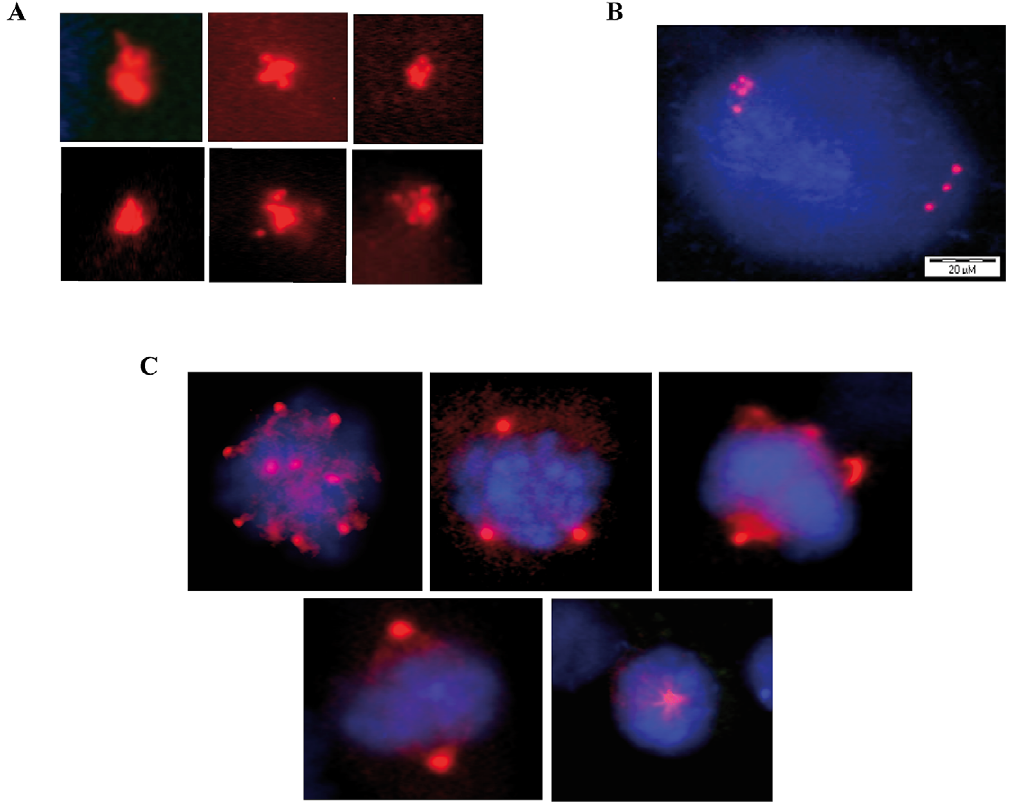
Fig. 5. Immunofluorescence with anti- γ -tubulin antibody (red) showing morphological features of aberrant centrosomes in the glioma cell lines. Magnification 63 × or 100 × . Scale bars = 20 µm (A, B, C). DNA was counterstained with DAPI (blue). (A) Centrosomes with a clustered distribution and similar morphology in the different cell types. (B) Abnormal distribution of centrosomes at nuclear poles in a cell entering mitosis. (C) Abnormal mitotic spindles: multipolar, tripolar, bipolar with one centrosome at one pole and three at the other, pseudobipolar with larger centrosomes than those of a normal bipolar spindle,